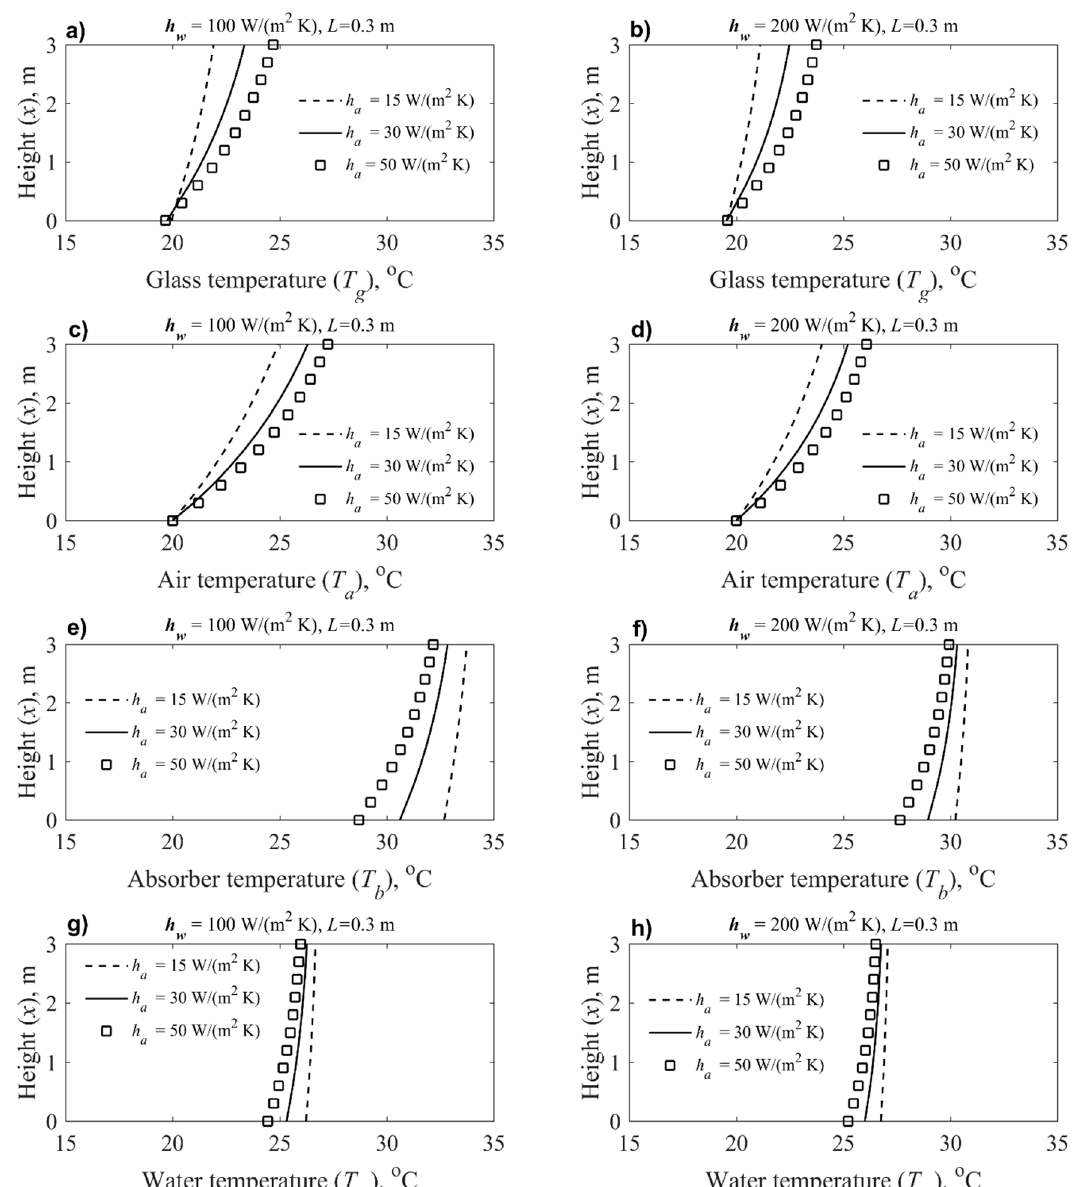
Figure 6. The temperature variations of the different elements of the system: ( a , b ) glass temperature; ( c , d ) air temperature; ( e , f ) absorber temperature; ( g , h ) water temperature as a function of the system height for the tank of 0.3 m in width, after 5 h. Subfigures ( a , c , e and g ) are obtained for h w = 100 W/(m 2 ·K) while ( b , d , f and h ) for h w = 200 W/(m 2 ·K).